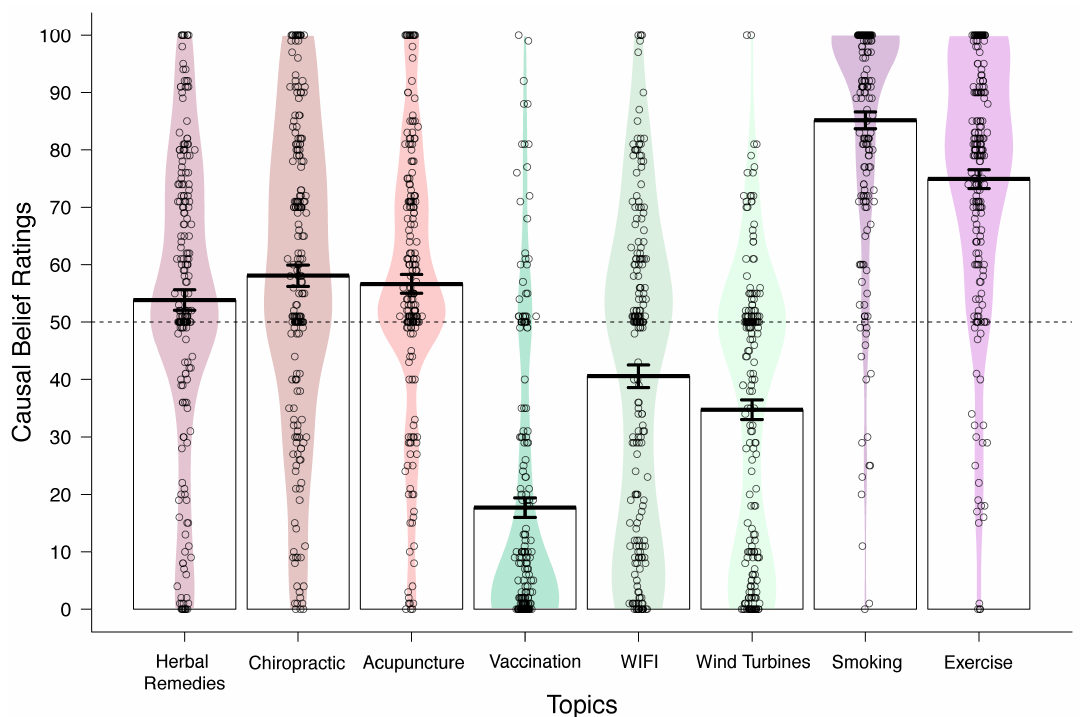
Figure 1. Plot of the density of responses ( n = 210) on the causal belief question for each target topic area grouped by belief type. Each circle represents a participant’s response, and the coloured region reflects the density of the responses along the Y -axis. Mean causal rating ( ± SE) across all respondents is denoted by a bold black